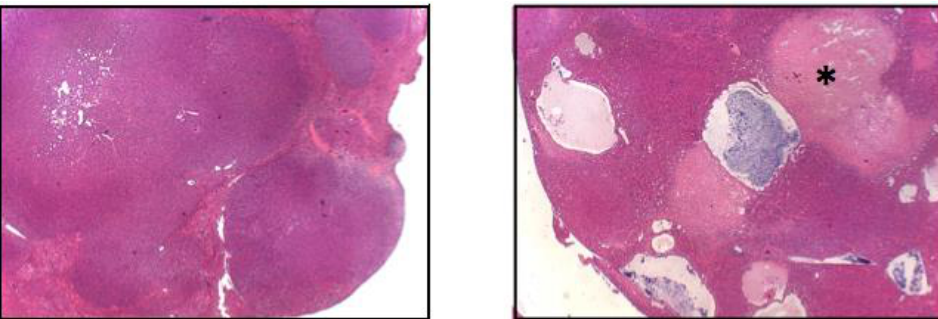
Figure 1. The co-expression of ∆ (90) β -catenin, YAP S127A and L30P/R34P induces HBs with widespread cyst formation and necrosis. Low power (5 × ) images of H&E stained tumor HBs. The ( left panel ) shows the typical crowded fetal-like appearance associated with the co-expression of ∆ (90) β -catenin and YAP S127A [20,30,35]. The ( right panel ) shows a tumor generated by the combined over-expression of ∆ (90) β -catenin + YAP S127A + R34P. Note the cysts and adjacent regions of widespread necrosis (asterisk). See [48] for additional, higher-power H&E-stained images of the crowded fetal morphology (Reprinted with permission from ref. [48]. Copyright 2021 Children’s Hospital of Pittsburgh of UPMC).